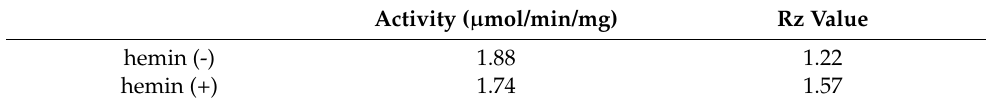
Activity ( μ mol/min/mg) Rz Value hemin (-) 1.88 1.22 Table 1. Peroxidase activity of SaDyP1 purified with or without hemin using ABTS as a substrate. hemin (+) 1.74 1.57 Activity ( µ mol/min/mg) Rz Value hemin (-) 1.88 1.22 hemin (+) 1.74